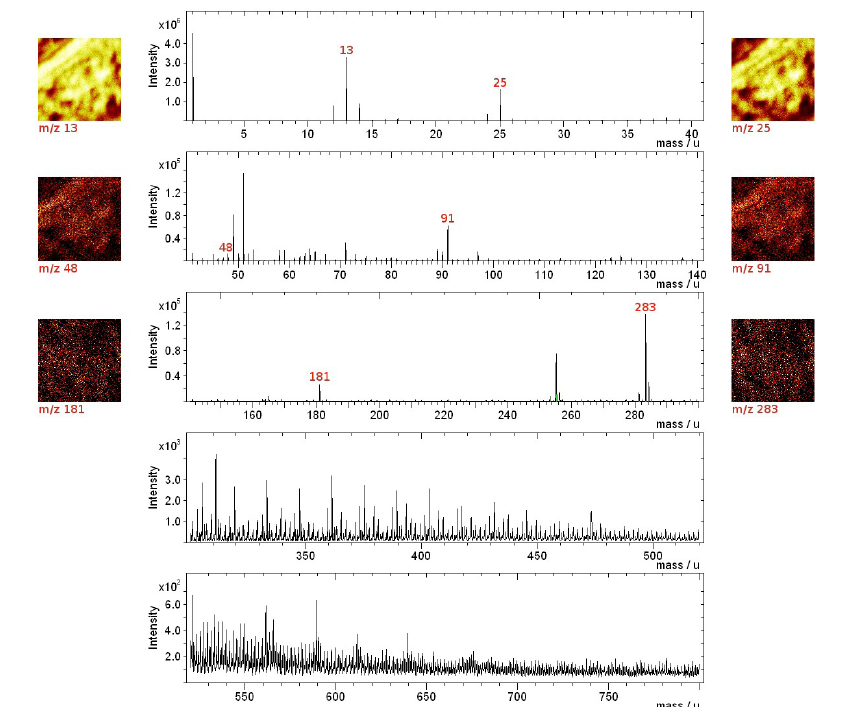
Figure 3. SIMS spectra of mercaptoacetic acid SAM onto the Ag in negative mode.